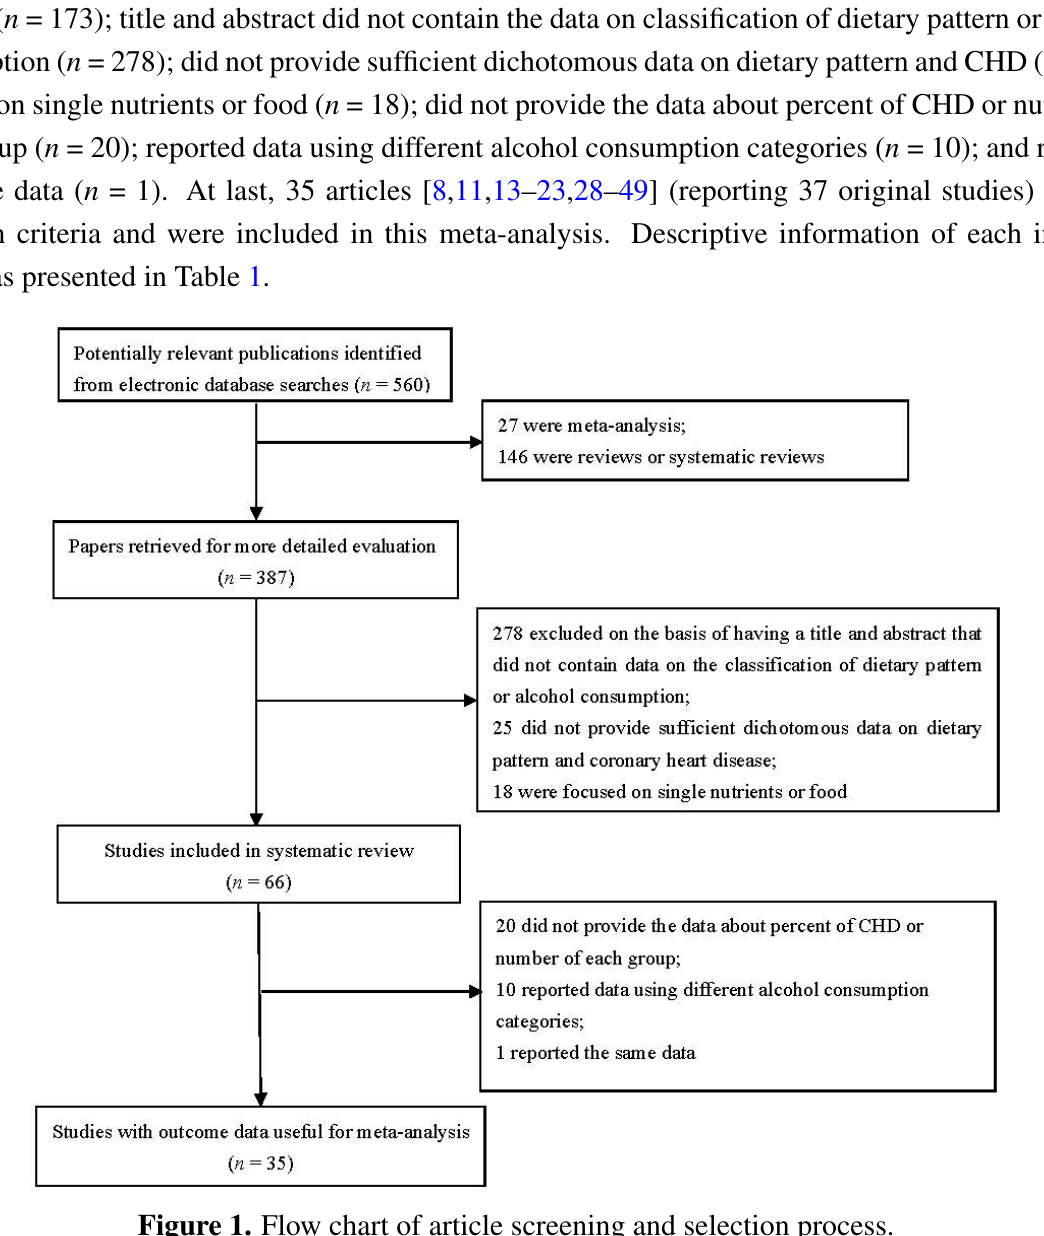
Figure 1. Flow chart of article screening and selection process.